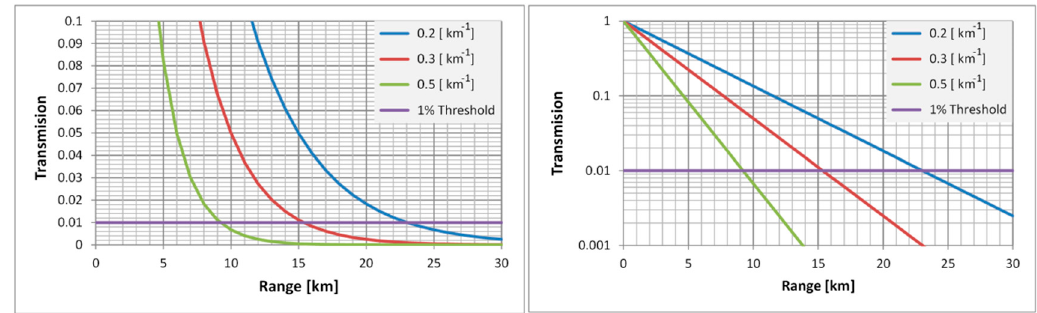
Figure 8. Atmospheric transmission value dependence on range and attenuation coefficient ( Left : log-linear scale; Right : linear scale).